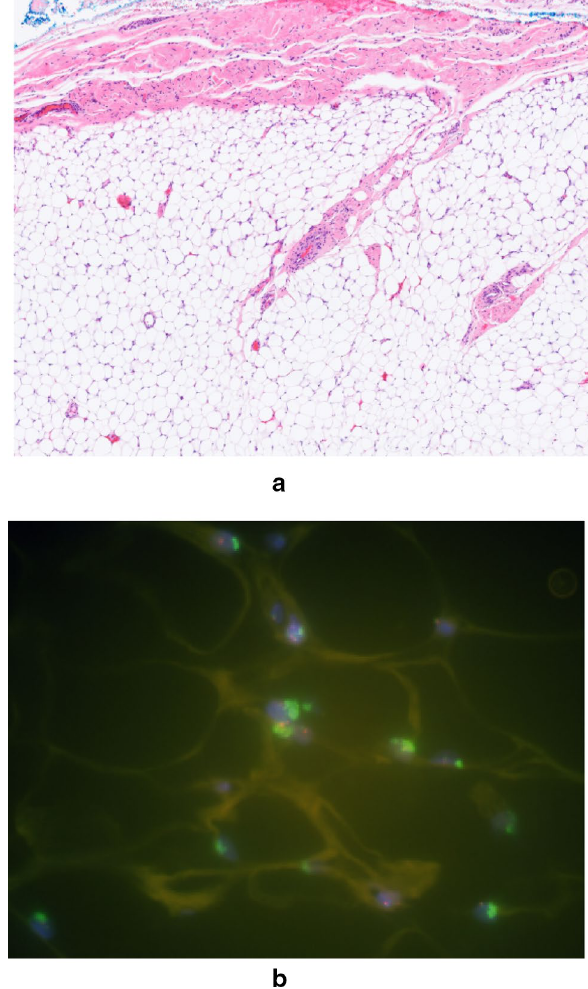
Fig. 3 a HE stains of the peri- tumoral fat showing incon- spicious lipocytes without atypic vascularization oder atypias. b Fluorescence in situ hybridization analysis of the liposarcomatous compo- nent with clusters of MDM2 amplification depicted by the brighter